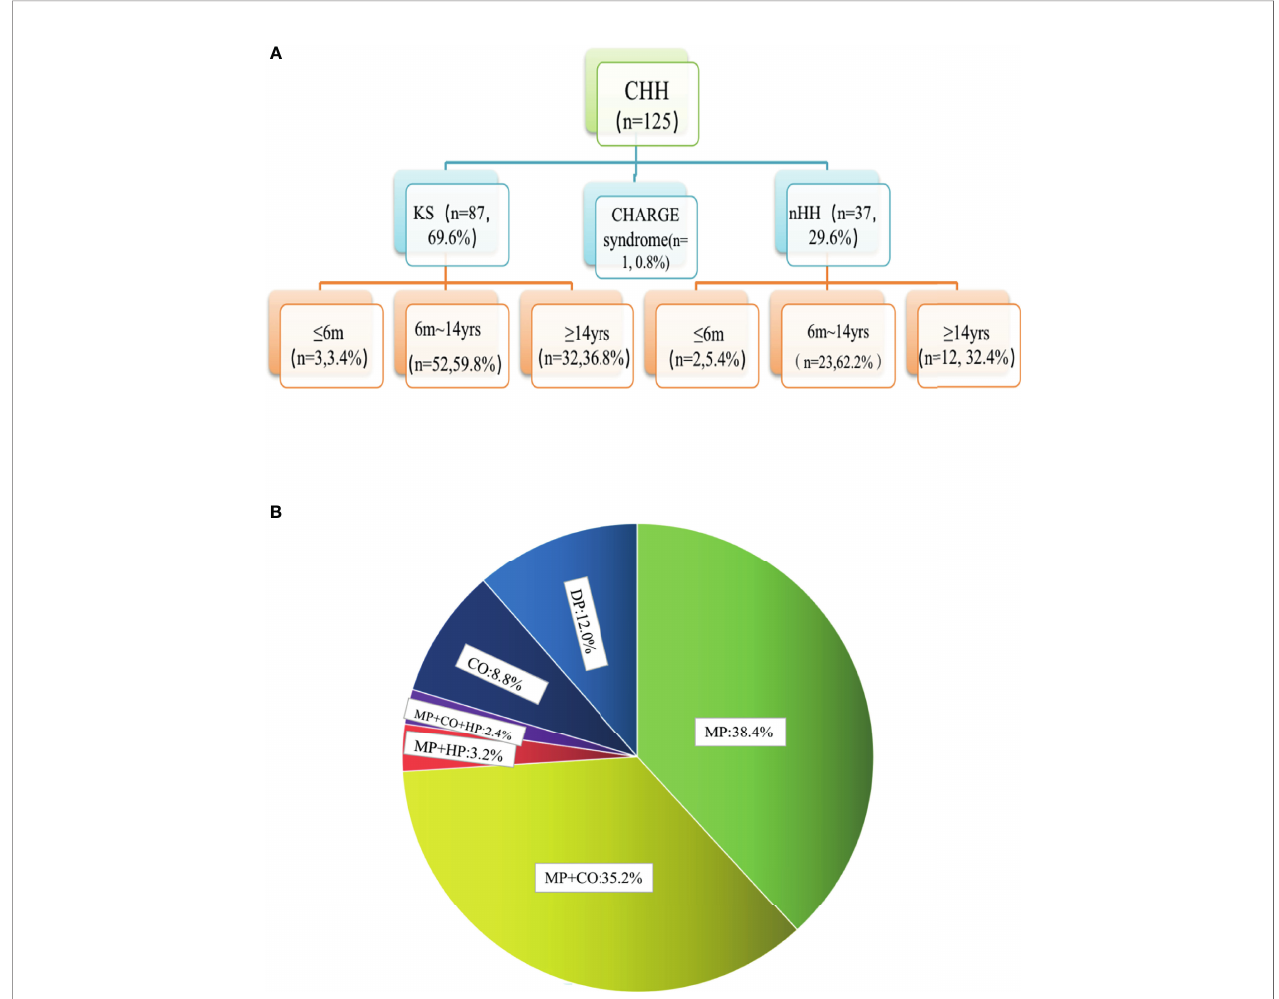
FIGURE 1 | Age distribution and phenotypic proportion of 125 patients with CHH. (A) In our group of patients with KS and nHH, more than half were diagnosed before the age of 14, one third were diagnosed over the age of 14, and a few cases could be diagnosed within 6 months due to the lack of puberty. (B) 80.0% of the patients had micropenis, including those with micropenis (38.4%), micropenis with cryptorchidism (35.2%), micropenis with cryptorchidism and hypospadias (2.4%), micropenis with hypospadias (3.2%), 8.8% of the patients had cryptorchidism and 12.0% had absent puberty. MP, micropenis, CO, cryptorchidism; HP, hypospadias; DP, delayed